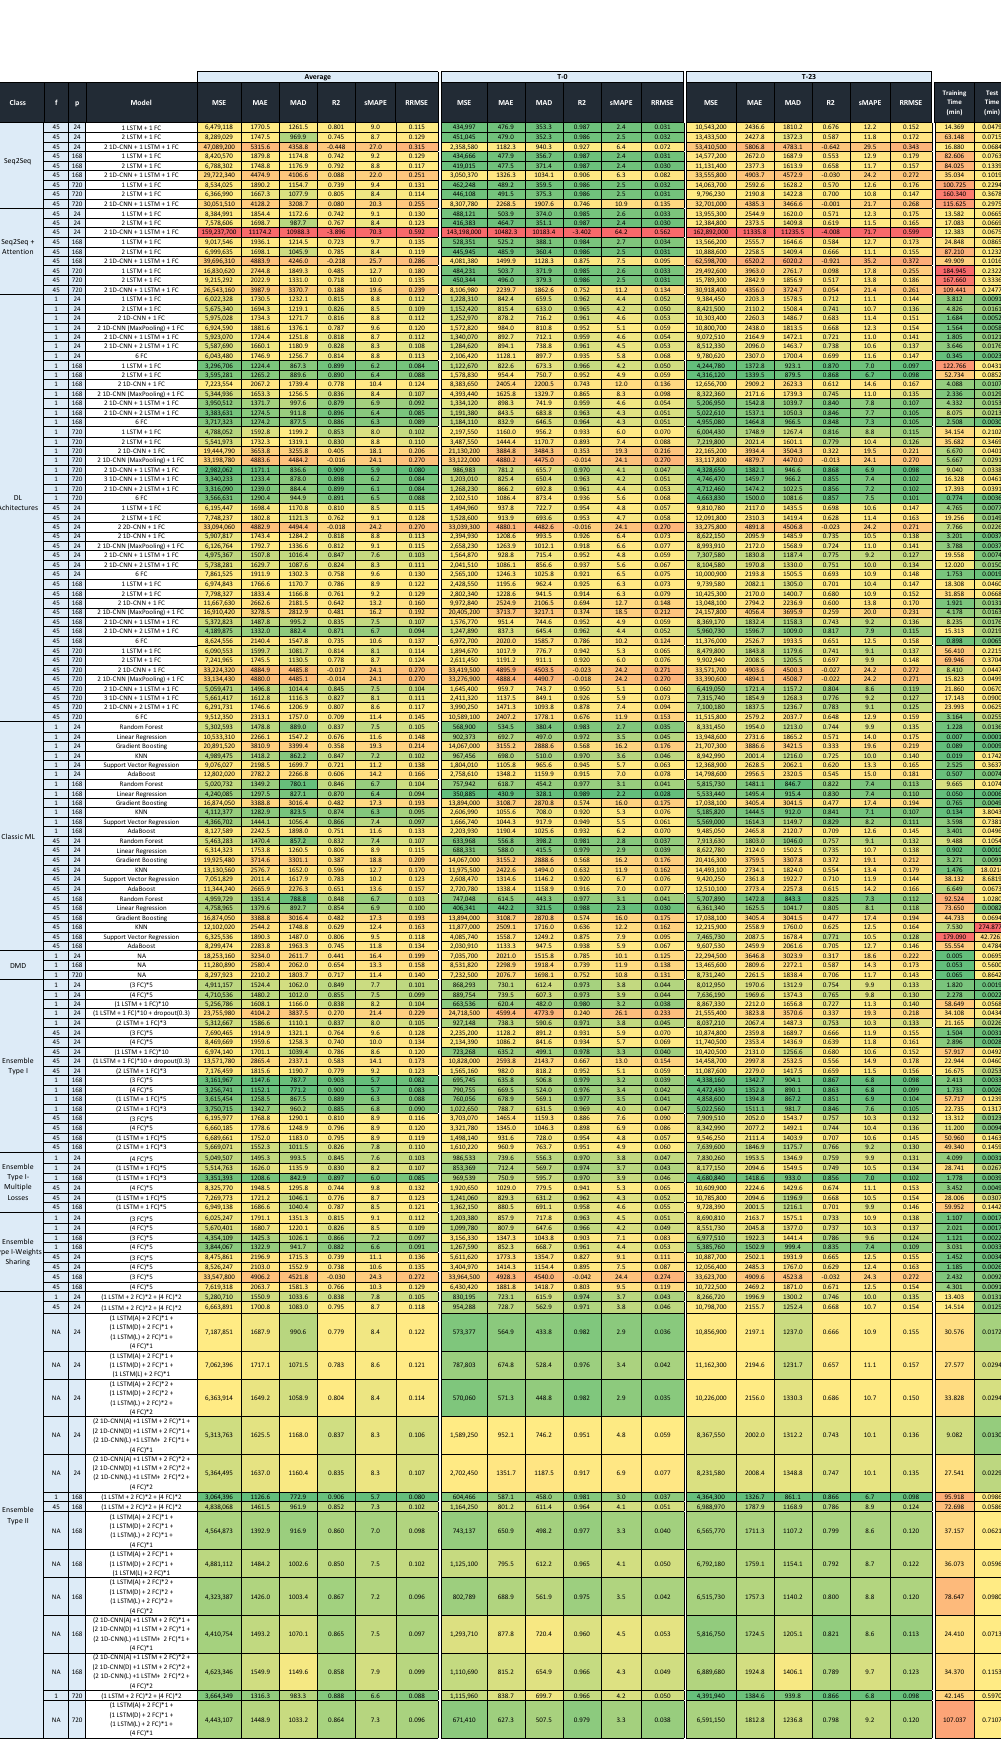
Figure A1. Forecast metrics for the average, first (T-0), and last (T-23) predicted time-slots for all